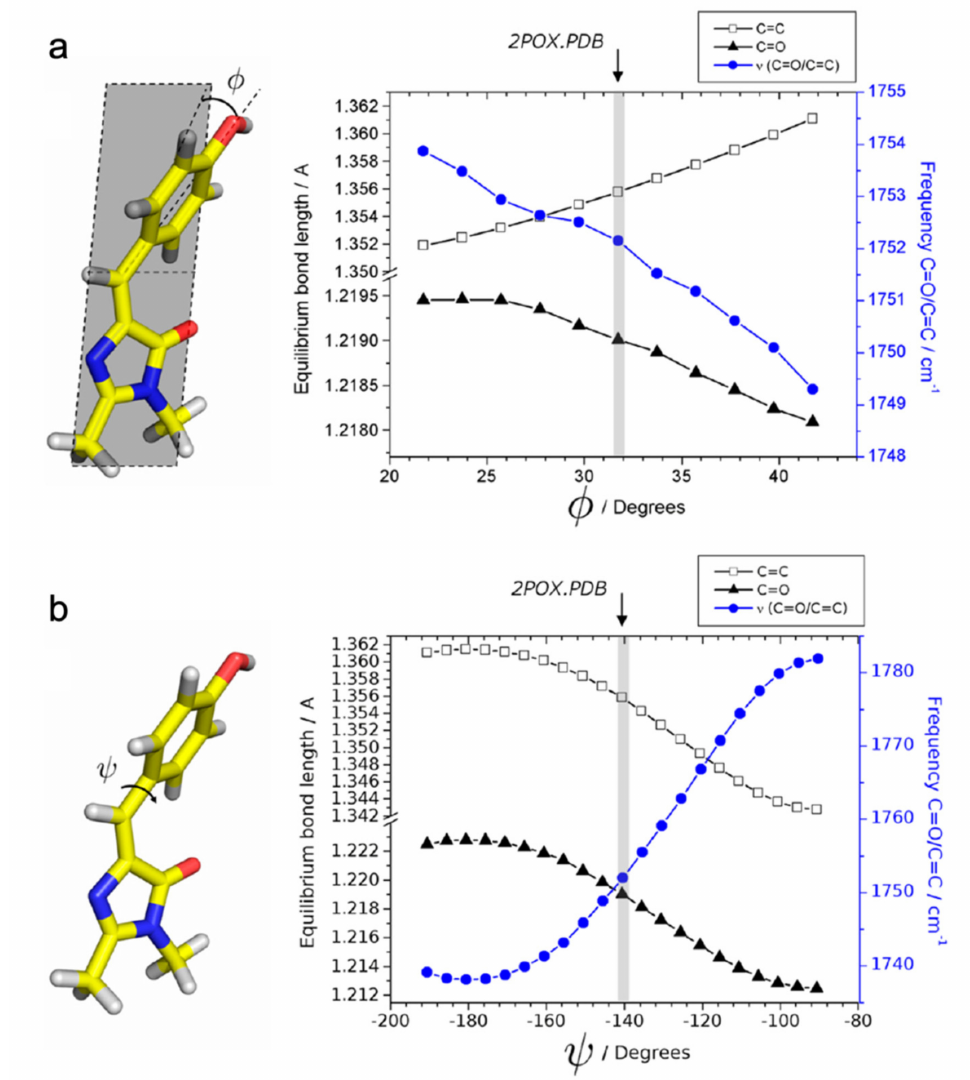
Figure 4. Dihedral-angle dependence of the calculated vibrational frequency and bond lengths of the neutral HBDI chromophore. ( a ) Dependence on the Φ angle (phenol ring out-of-plane bending). ( b ) Dependence on the ψ angle (phenol ring torsion). Angles ( Φ = 32 ◦ , ψ = − 140 ◦ ) corresponding to the off-state Dronpa crystal structure (PDB ID: 2POX) [32] are denoted by the gray vertical bars. Reprinted with permission from Ref. [63]. Copyright 2014 American Chemical